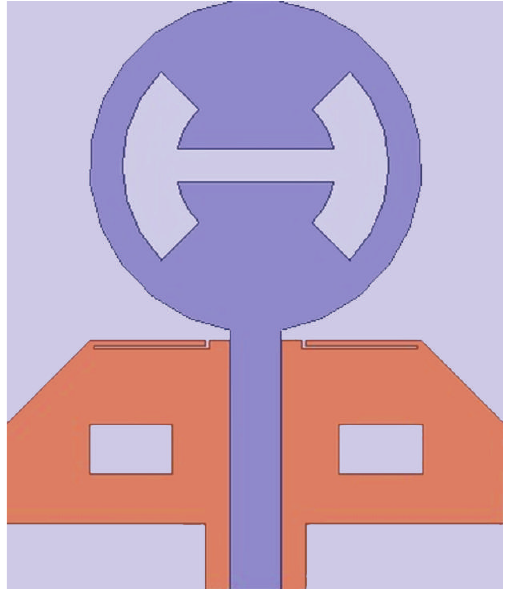
Figure 9: Geometry of the proposed